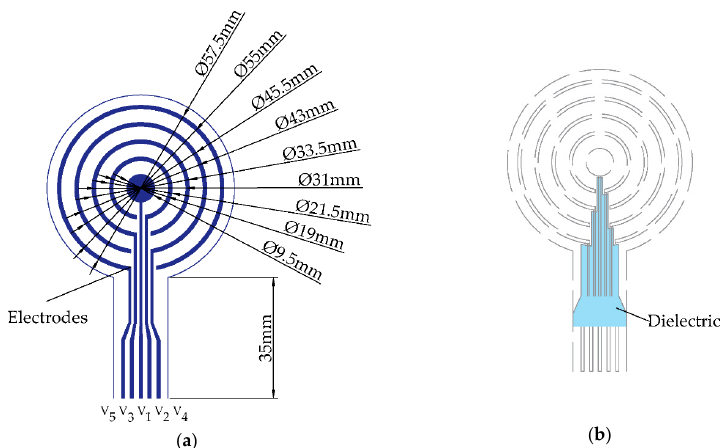
Figure 1. Bilayer design of the concentric ring electrode (CRE): ( a ) recording surfaces including the central disc and open rings along with their dimensions; ( b ) dielectric layer to avoid shorts.